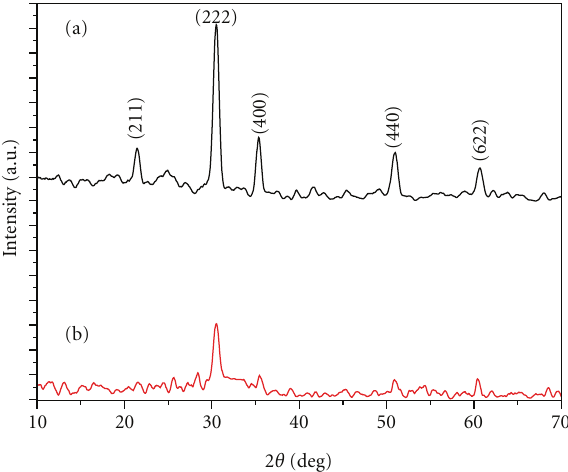
Figure 2: XRD patterns of (a) commercial and (b) RF-sputtered ITO thin